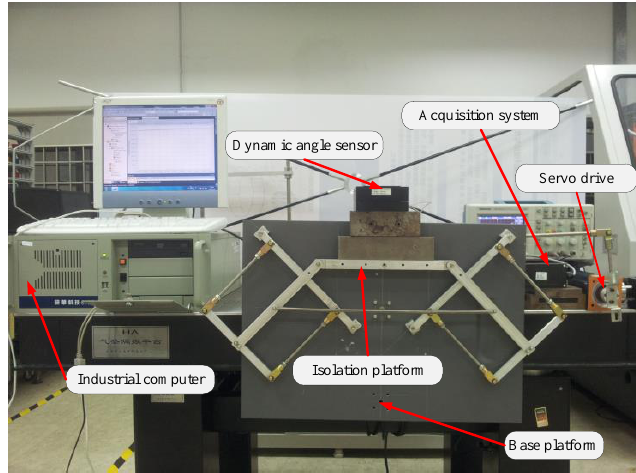
Figure 9. Experimental vibration isolation system. Appl. Sci. 2017 , 7 , 367